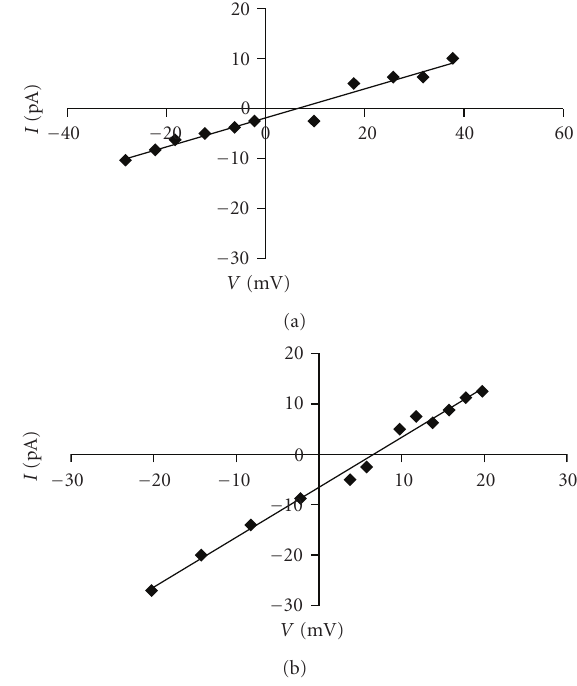
Figure 7: A β P1-40 channel ion selectivity in OxCh PLM. A β P1-40 channel selectivity in the presence of choline (5 × 10 − 11 M) cis (a) or trans (b) in OxCh PLM. The amplitude of the channel current (pA) is plotted as a function of the transmembrane potential ( V ). Conductance was determined by linear regression of the current values from − 30/ − 20 mV to 40/20 mV (choline cis / trans ) in asymmetrical solutions 100 mM/50 mM KCl cis / trans . Intercept (5.76/7.76 mV, choline cis / trans ) was used to calculate P K + / P Cl −